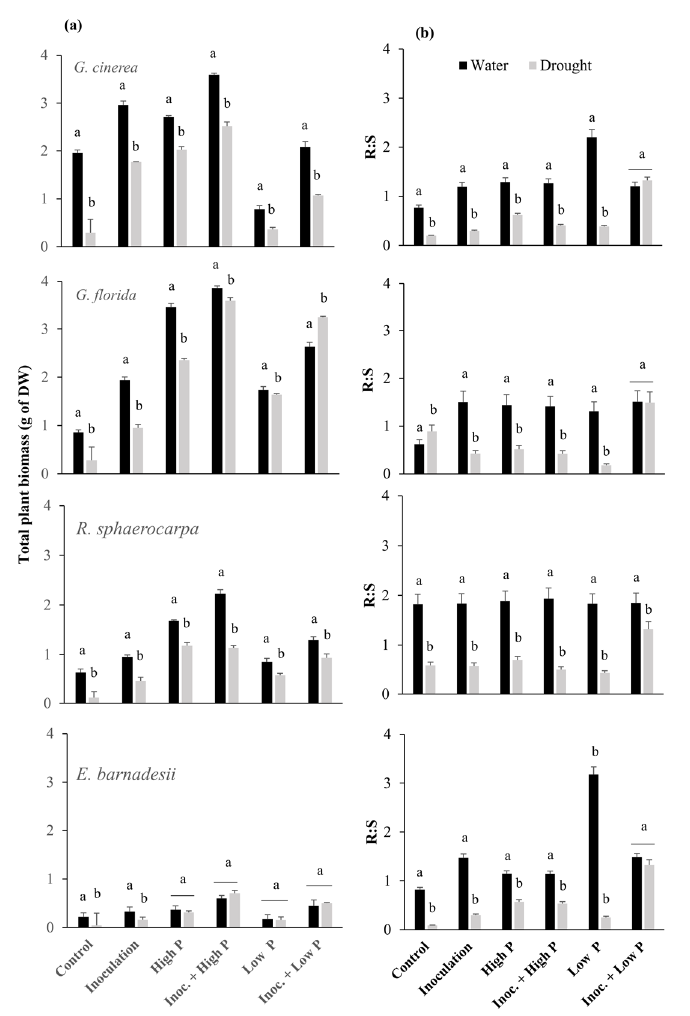
Figure 2. Plant dry weights ( a ) and shoot:root ratio ( b ) of G. cinerea , G. florida , E. barnadesii and R. sphaerocarpa after receiving either 500 µ M P (High) or 5 µ M P (Low) nutrient solutions with and without bacterial inoculation, under two water regimes: Irrigation (Water) and drought stress (drought). Values are presented as means ( n = 15) with standard error bars and letters indicating significant di ff erences among treatments using the post-hoc Fisher’s LSD, multiple range test ( p ≤ 0.05). Growth rate was significantly reduced in the drought treatment in the four species (Table